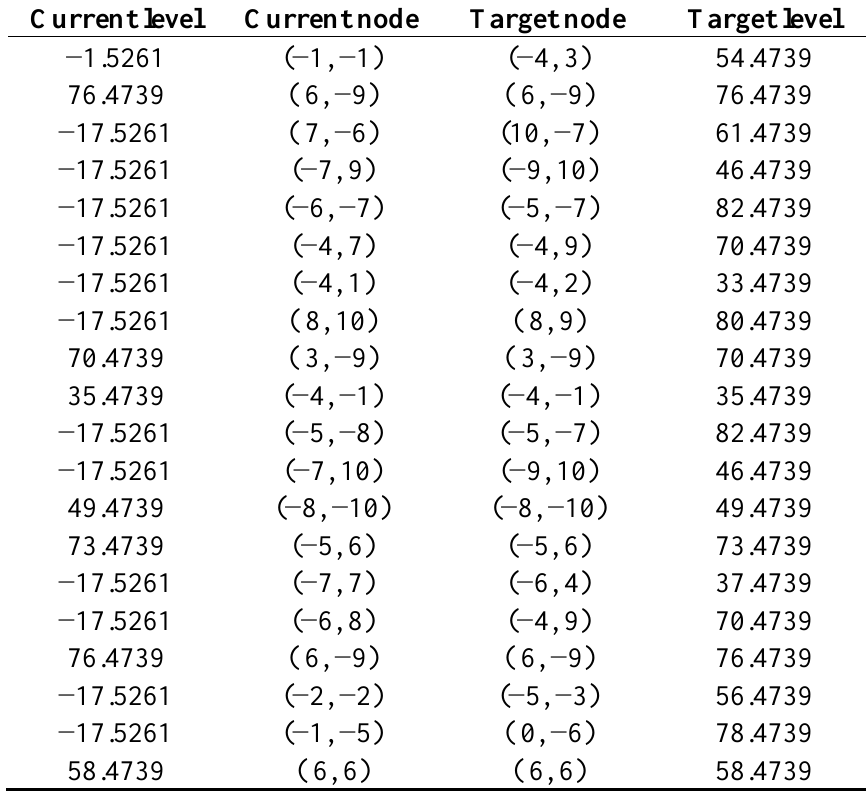
Table 1. Navigation